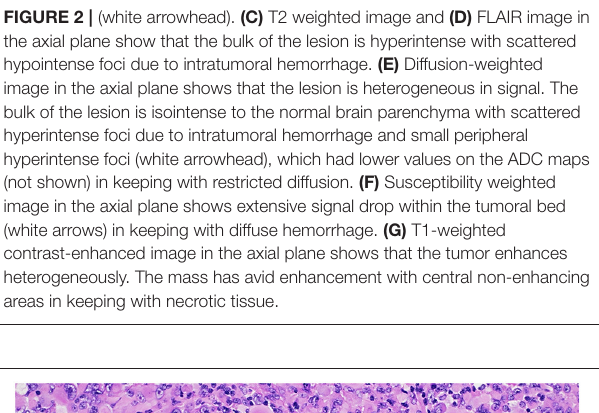
FIGURE 2 | (white arrowhead). (C) T2 weighted image and (D) FLAIR image in the axial plane show that the bulk of the lesion is hyperintense with scattered hypointense foci due to intratumoral hemorrhage. (E) Diffusion-weighted image in the axial plane shows that the lesion is heterogeneous in signal. The bulk of the lesion is isointense to the normal brain parenchyma with scattered hyperintense foci due to intratumoral hemorrhage and small peripheral hyperintense foci (white arrowhead), which had lower values on the ADC maps (not shown) in keeping with restricted diffusion. (F) Susceptibility weighted image in the axial plane shows extensive signal drop within the tumoral bed (white arrows) in keeping with diffuse hemorrhage. (G) T1-weighted contrast-enhanced image in the axial plane shows that the tumor enhances heterogeneously. The mass has avid enhancement with central non-enhancing areas in keeping with necrotic tissue.